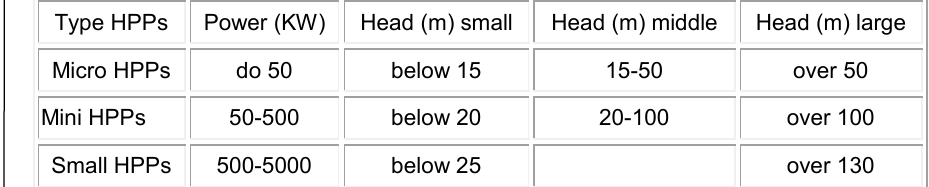
Table 1 – Types of mini hydropower plants Таблица 1 – Виды мини - ГЭС Tabela 1 – Vrste